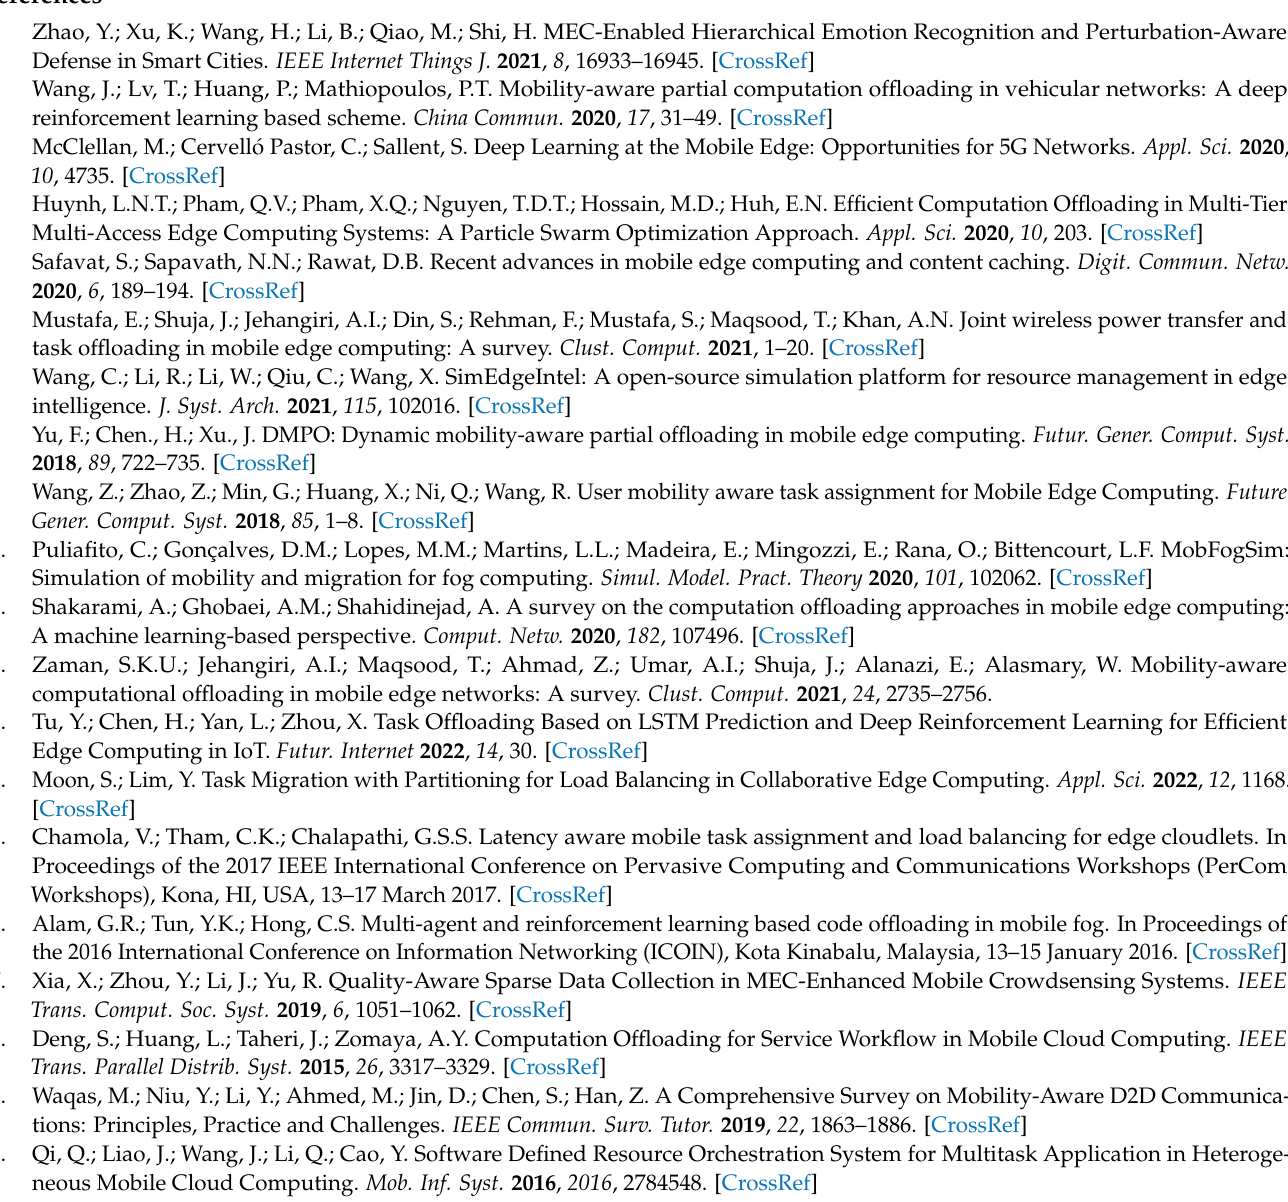
Figure A3. Learning model evaluation : ( a ) epoch loss; ( b ) root mean square error.